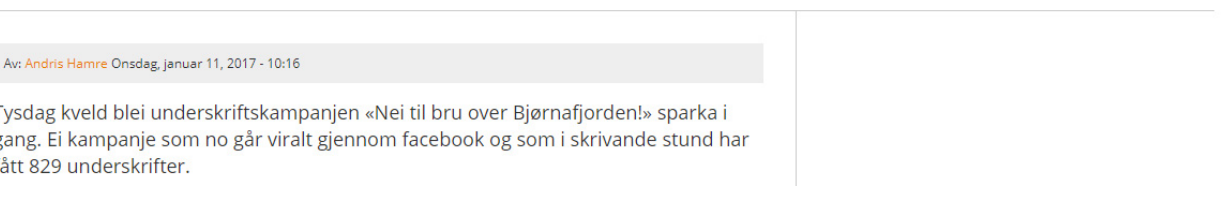
Figure 5. Politics: online petition goes analog.